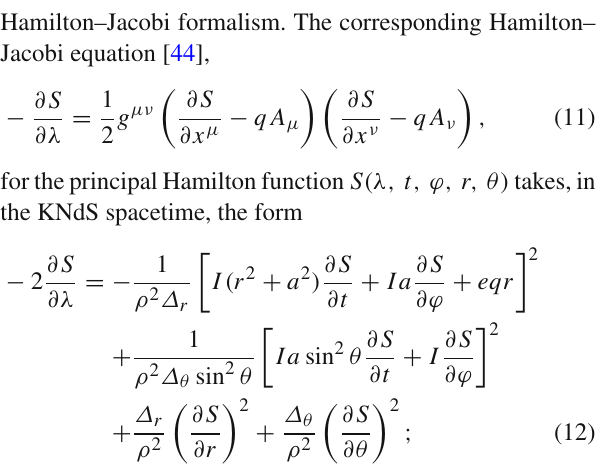
Fig. 1 Profiles of the function y h ( r ; a , e ) for a fixed value of the parameter a and various values of the parameter e , b fixed value of the parameter e and various values of the parameter a . Dashed profiles